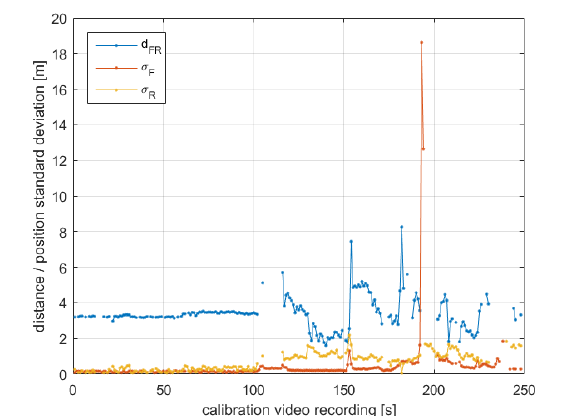
Figure 8: Distance d FR between vehicle front and rear camera plotted over the time of the calibration drive videos, as well as the position standard deviation of the vehicle front camera σ F and vehicle rear camera σ R . Gaps in the plot occur, if a camera pose could not be estimated for a specific time point. The plot shows stable values while the vehicle is standing, a lower accuracy while the vehicle is moving. Line between discrete poses drawn for better visualization.